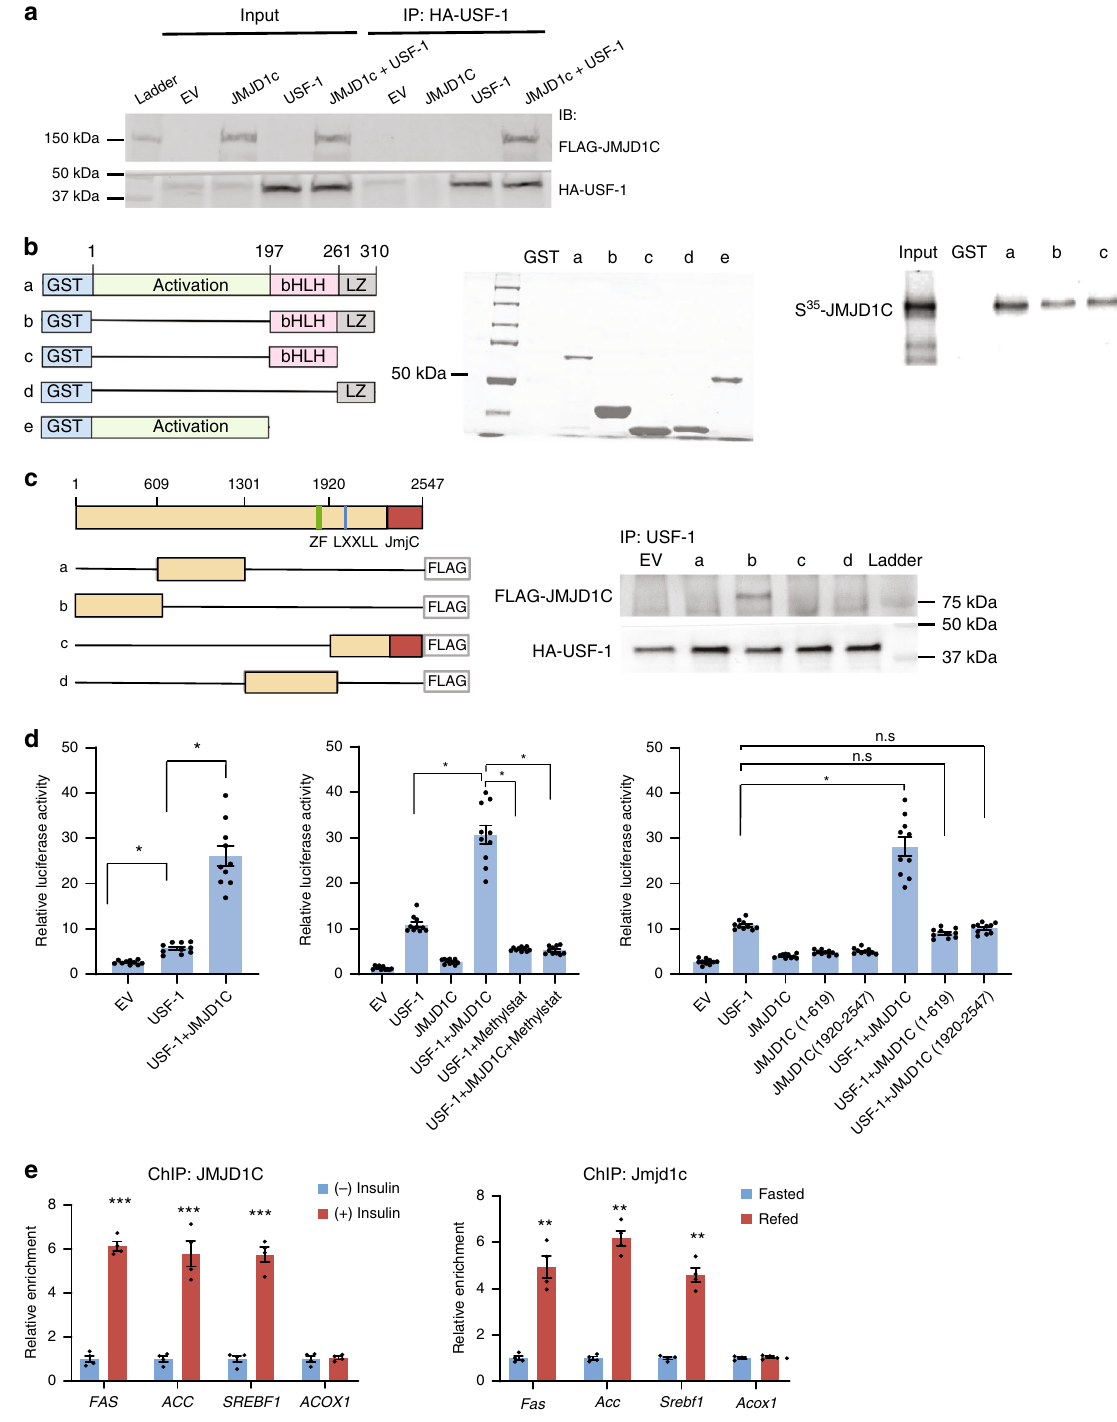
Fig. 1 JMJD1C interaction with USF-1 for FAS promoter activation. a IB of cell lysates of HEK293 cells co-transfected Flag-JMJD1C and HA-USF-1 with Flag antibody after IP with HA antibody (left). Immunoblotting of liver lysates from fasted and fed mice after IP with JMJD1C antibody (top right) and USF-1 antibody (bottom right). b Diagram of GST-USF-1 constructs (left). Coomassie Blue staining of SDS-PAGE of puri fi ed GST-USF-1 protein from bacterial lysates (middle). In vitro transcribed and translated S 35 -methioine labeled JMJD1C was incubated with GST-USF-1 and subjected them to SDS-PAGE, followed by autoradiography (right). c Diagram of JMJD1C constructs (left). Co-IP of 293FT cells overexpressing Flag-tagged JMJD1C and USF-1. Immunoblotting with anti JMJD1C antibody after IP with USF-1 antibody (right). d FAS promoter activity in 293FT cells that we co-transfected with USF-1 with or without JMJD1C (left), with or without 10 µ M Methylstat (Sigma), JMJD1C inhibitor (middle), and after overexpression of various deletions of JMJD1C (left). n = 10 wells of cells per group. Experiment was repeated three times. e ChIP for FAS , ACC , and SREBPF1 promoters in HepG2 cells with or without insulin treatment (left, n = 4 per group) and ChIP for Fas , Acc1 , and Srebf1 promoters in liver from fasted or fed mice (right, n = 3 per group) after IP with JMJD1C antibody. Data are expressed as means ± SEM. ** P < 0.01, *** P < 0.001, determined by two-tailed t -test. Source data are provided as a source data fi